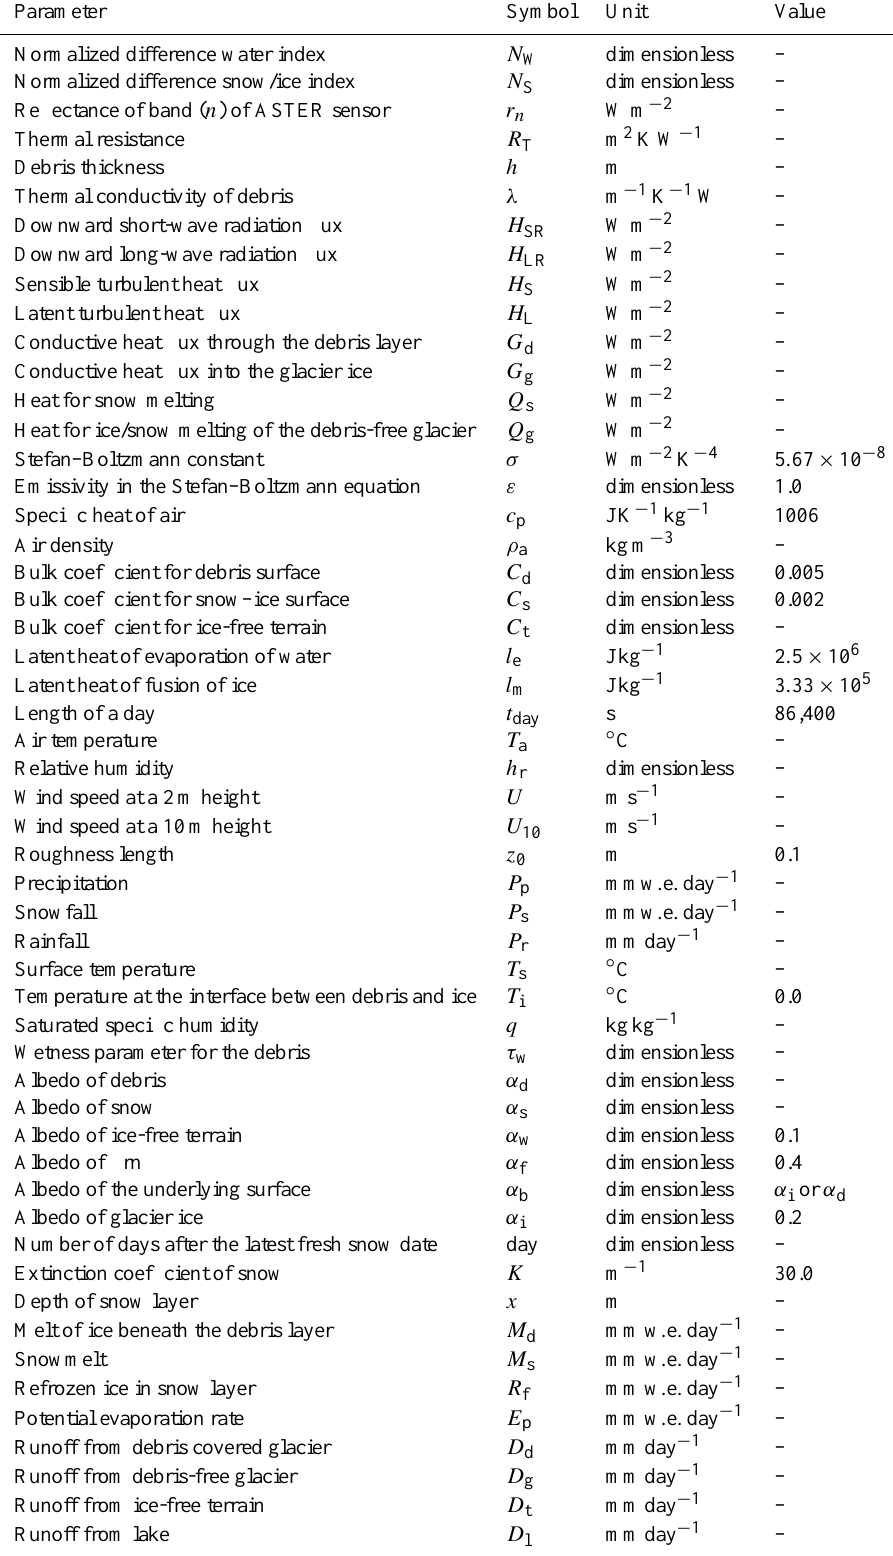
Potential evaporation